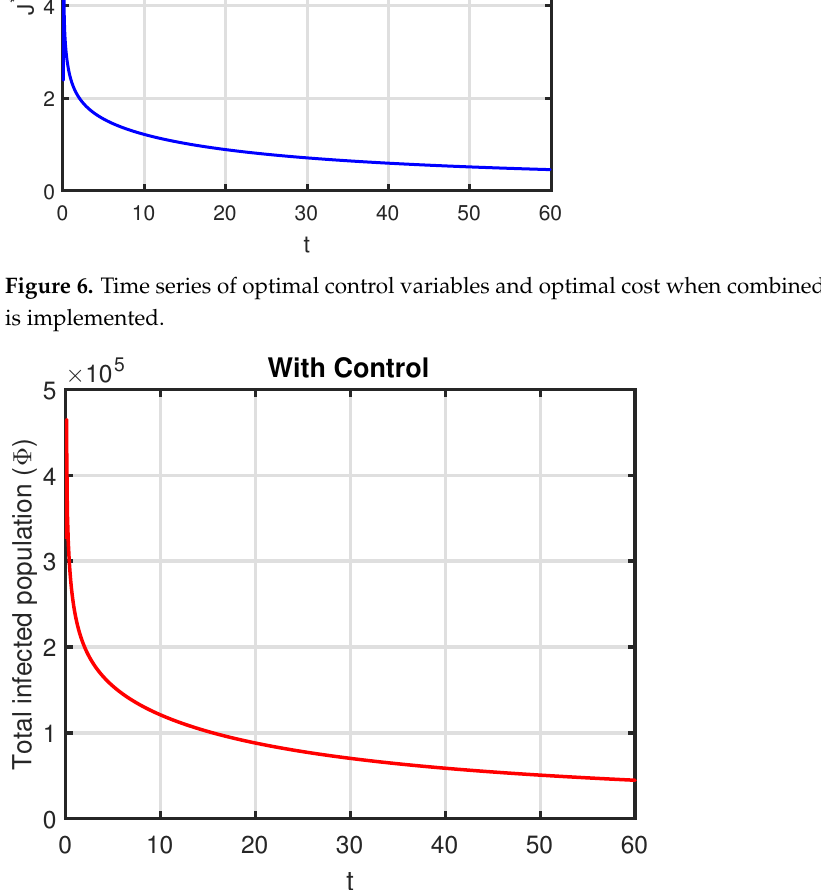
Figure 7. Time series of total infected population ( I + C ) when control is